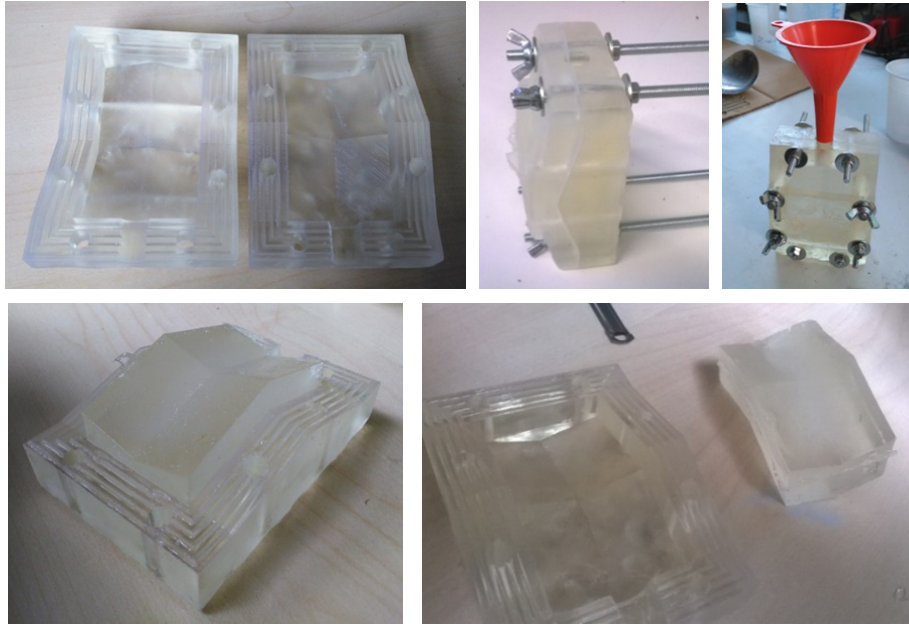
Fig. 10 3D printed moulds for exploratory casting experiments with sugar